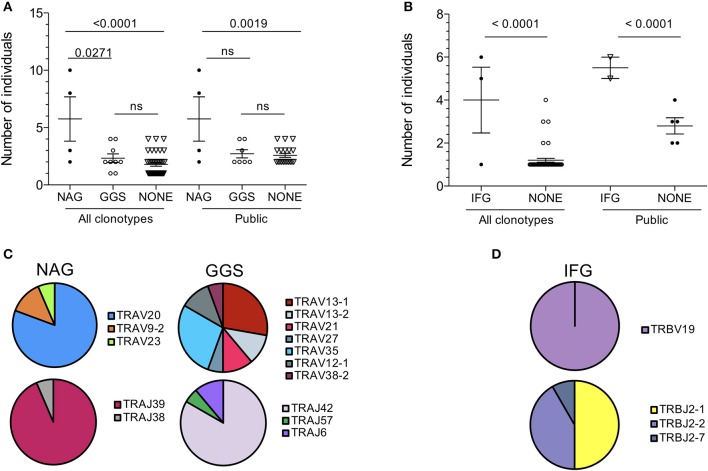
Amino acid motif conservation in public clonotypes from HLA-B*44:03/NW8-specific CD8+ T cells. (A) The number of individuals sharing NAG or GGS-containing TCR-α chains is shown. (B) The number of individuals sharing IFG-containing TCR-β chains is shown. (C) TRAV and TRAJ gene usage in NAG or GGS-containing TCR-α chains is illustrated as pie charts. Frequencies are calculated as fraction of NAG or GGS- containing amino acid sequences. (D) TRBV and TRBJ gene usage in IFG-containing TCR-β chains is illustrated as pie charts. Frequencies are calculated as fraction of IFG-containing amino acid sequences. Horizontal bars represent the mean and standard of the mean. Statistical significance is shown where p < 0.05 (ns = not significant). Pie charts illustrate the frequency of a V or J gene. Colours are assigned randomly and do not correspond to a fixed a sequence.